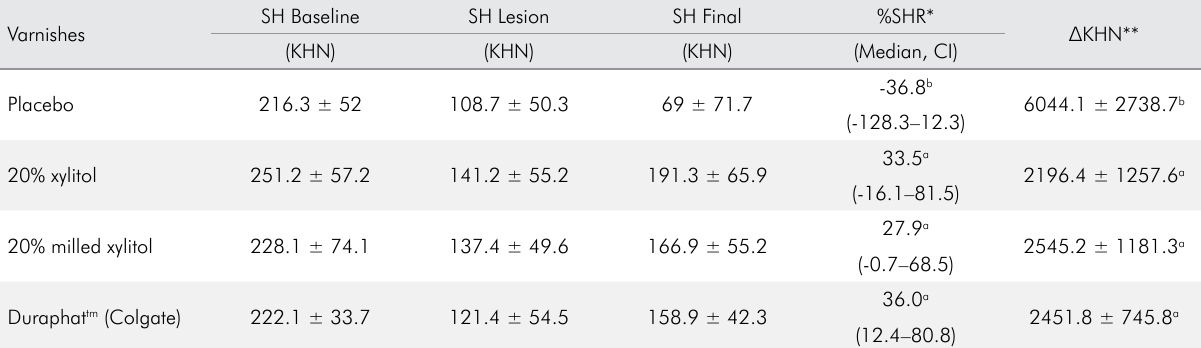
Table 1. Surface hardness measurements at baseline (SH baseline), after demineralization (surface hardness loss - %SHL), after treatment and pH cycling (SH final), percentage of surface hardness recovery (%SHR) and integrated mineral loss (ΔKHN) for the primary teeth in vitro (n = 15).